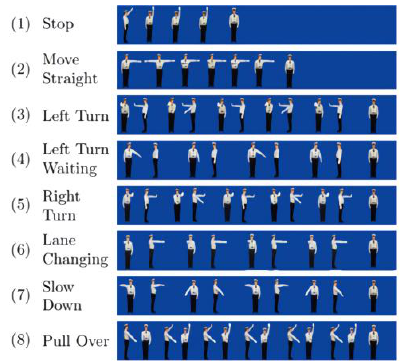
Figure 7. The eight gestures of Chinese traffic police [9].